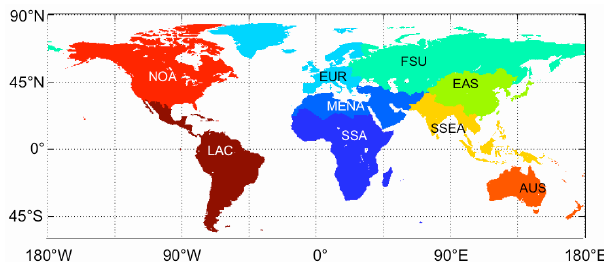
Fig. B2. Definition of socio-economic regions: North America (NOA), Latin America and Caribbean (LAC), Europe excluding former Soviet Union (EUR), former Soviet Union (FSU), Middle East and North Africa (MENA), Sub-Saharan Africa (SSA), East Asia (EAS), South and South-East Asia (SSEA), Australia, New Zealand and Pacific Islands (AUS).